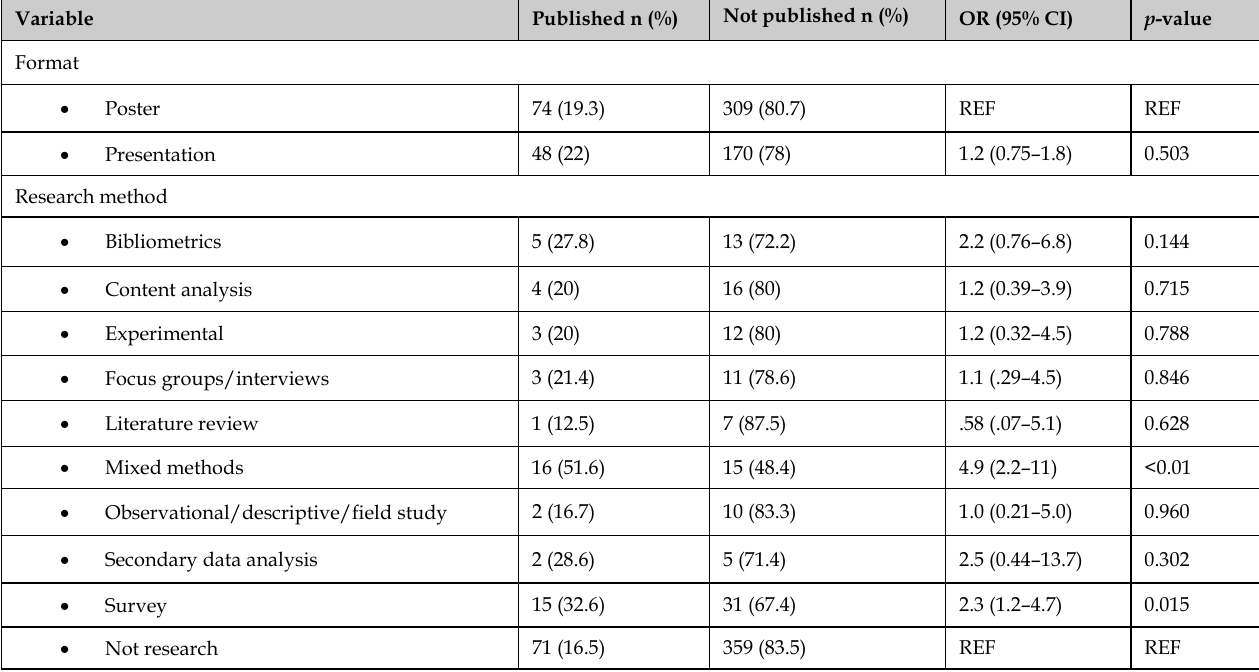
Table 5 Potential variables associated with publication: format and research method